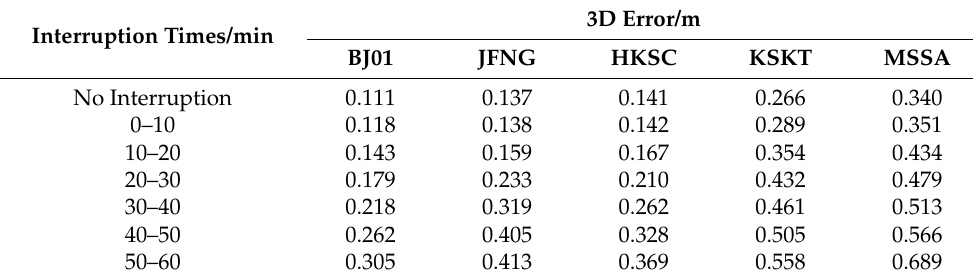
Table 6. Mean RMSE of 3D positioning error of the simulated kinematic PPP-B2b solutions at different times for the five stations during DOY 355–361 in 2022.